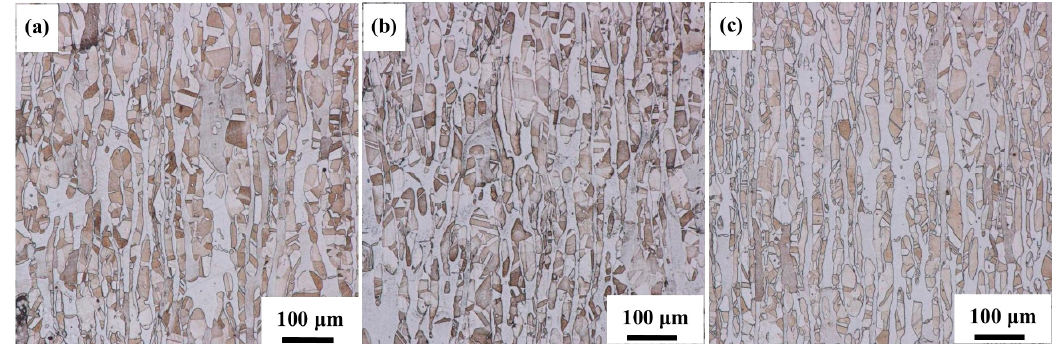
Figure 6. Photographs of grain observation of the 0#–2# experimental samples: ( a ) 0#; ( b ) 1#; ( c ) 2#.